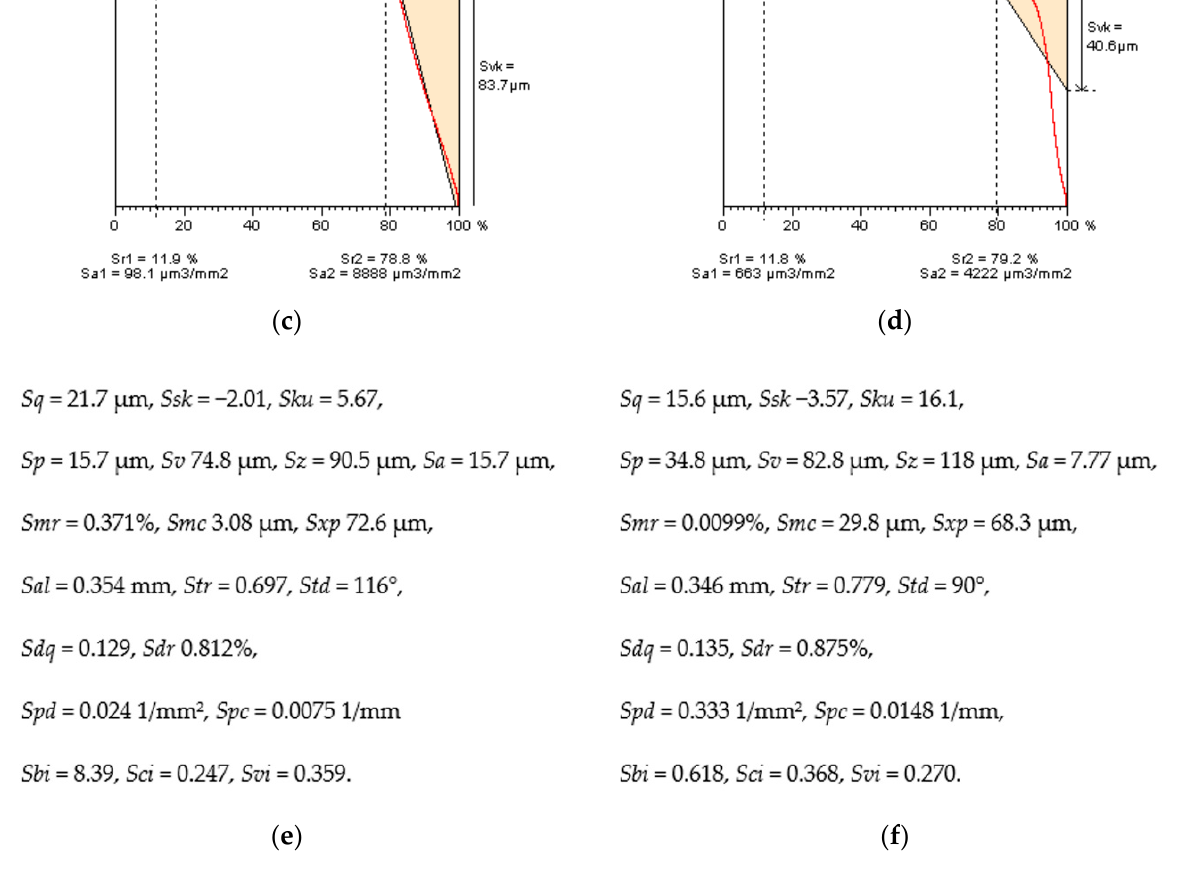
Figure 2. Isometric views ( a , b ), material ratio curves ( c , d ) and selected parameters ( e , f ) of plateau-honed cylinder liner surface topographies, containing oil pockets, in the running-in ( a , c , e ) and worn ( b , d , f ) stage of life, measured by the stylus instrument.